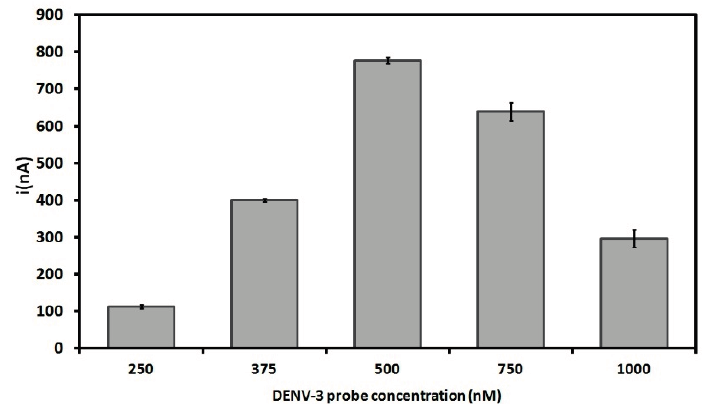
Figure 2. Electrochemical signals of different concentrations of DENV-3 probe onto pencil graphite electrodes (PGE). Differential pulse voltammetry (DPV) was used for electrochemical analysis based on guanine oxidation. Experimental conditions: Scanning potential range between +0.5 V and +1.2 V and scan rate of 0.05 V/s. The results represent the average of triplicates carried out at each DENV-3 probe